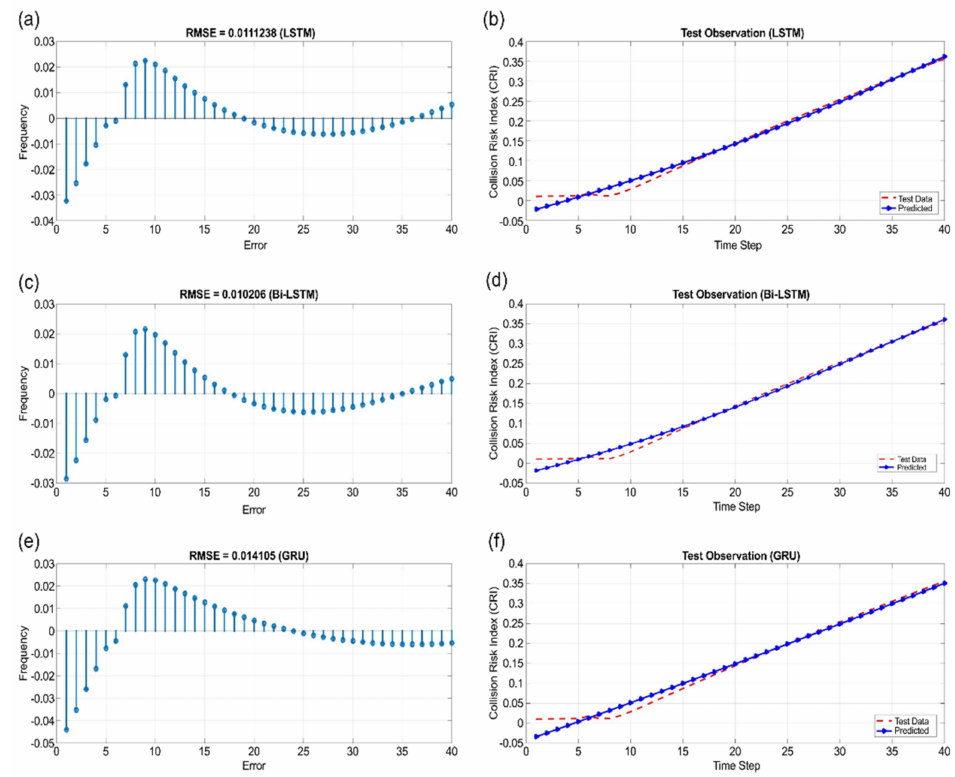
Figure 13. Sector VI: ( a ) RMSE of LSTM, ( b ) test observation of LSTM, ( c ) RMSE of Bi-LSTM, ( d ) test observation of Bi-LSTM, ( e ) RMSE of GRU, and ( f ) test observation of GRU.